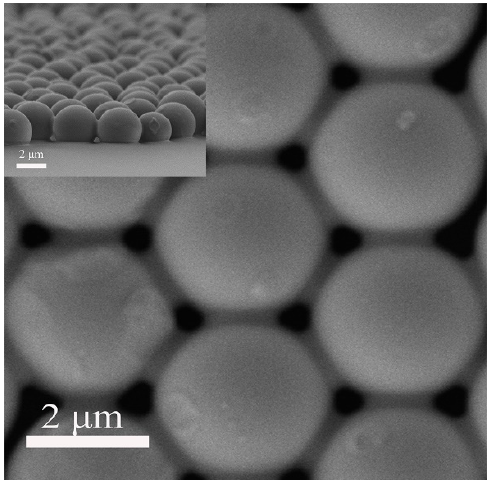
Figure 1. Top view SEM image of PS microspheres arranged in closely hexagonal packing on PSO/PDMS composite coating surface. The inset is a cross-sectional SEM image of the PSO/PDMS- PS composite coating.